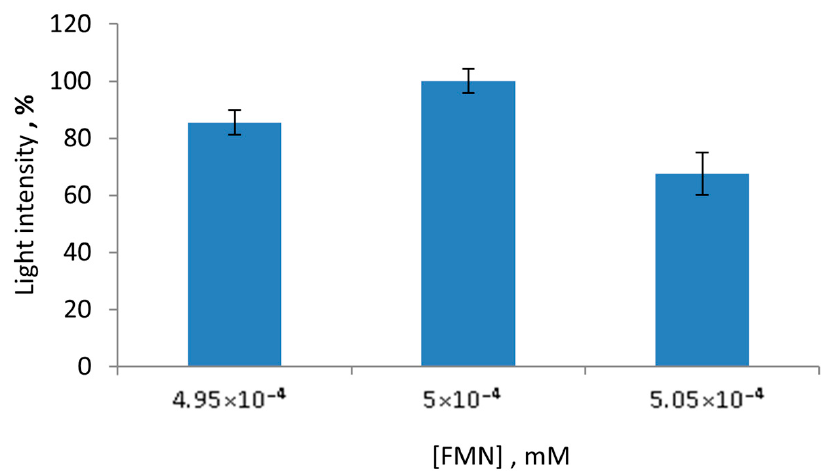
Figure 4. Values of light intensity of the LDH + Red + Luc enzyme system upon the FMN concentration variation.